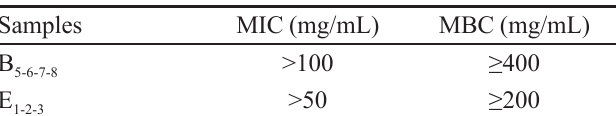
TABLE II - MIC and the MBC for P. aeruginosa on the basis of fresh